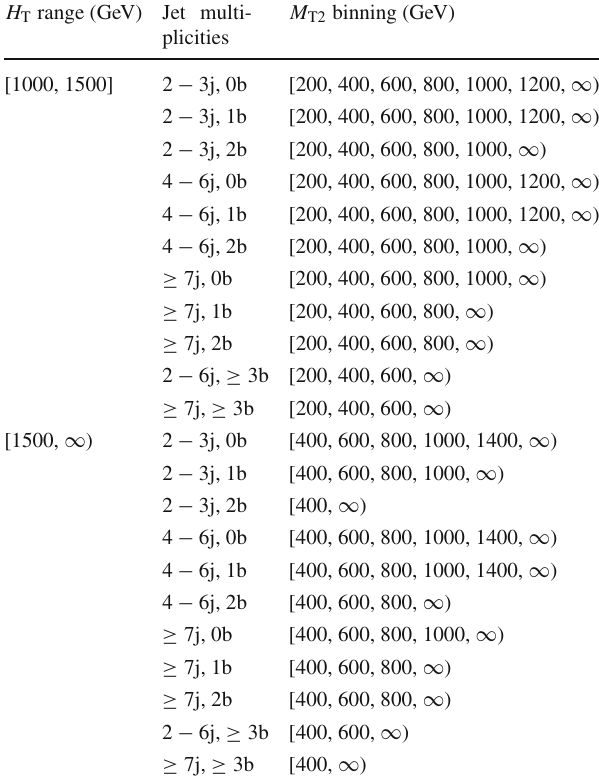
Table 7 The M T2 binning in each topological region of the multijet search regions, for the high- and extreme- H T regions H T range (GeV) Jet multi-